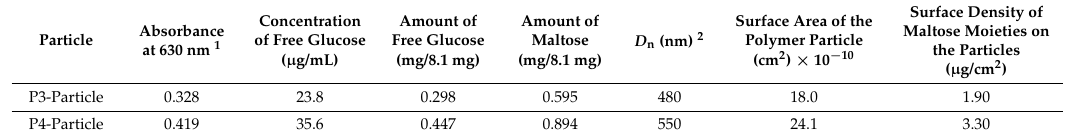
Figure 5. Transmittance of Mal-decorated polymer particle suspensions prepared using ( a ) P3 and ( b ) P4 after adding lectins for 2h. Control: polymer particle suspension before the addition of Con A and BSA. Table 3. Determination of maltose amounts on the Mal-decorated polymer particle